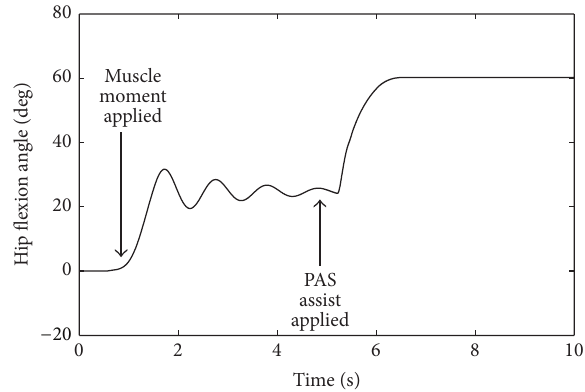
Figure 3: Simulated PAS operation. Hip angle of 25 ∘ was achieved before activation and assistive power of PAS was simulated to drive hip to 60 ∘ of